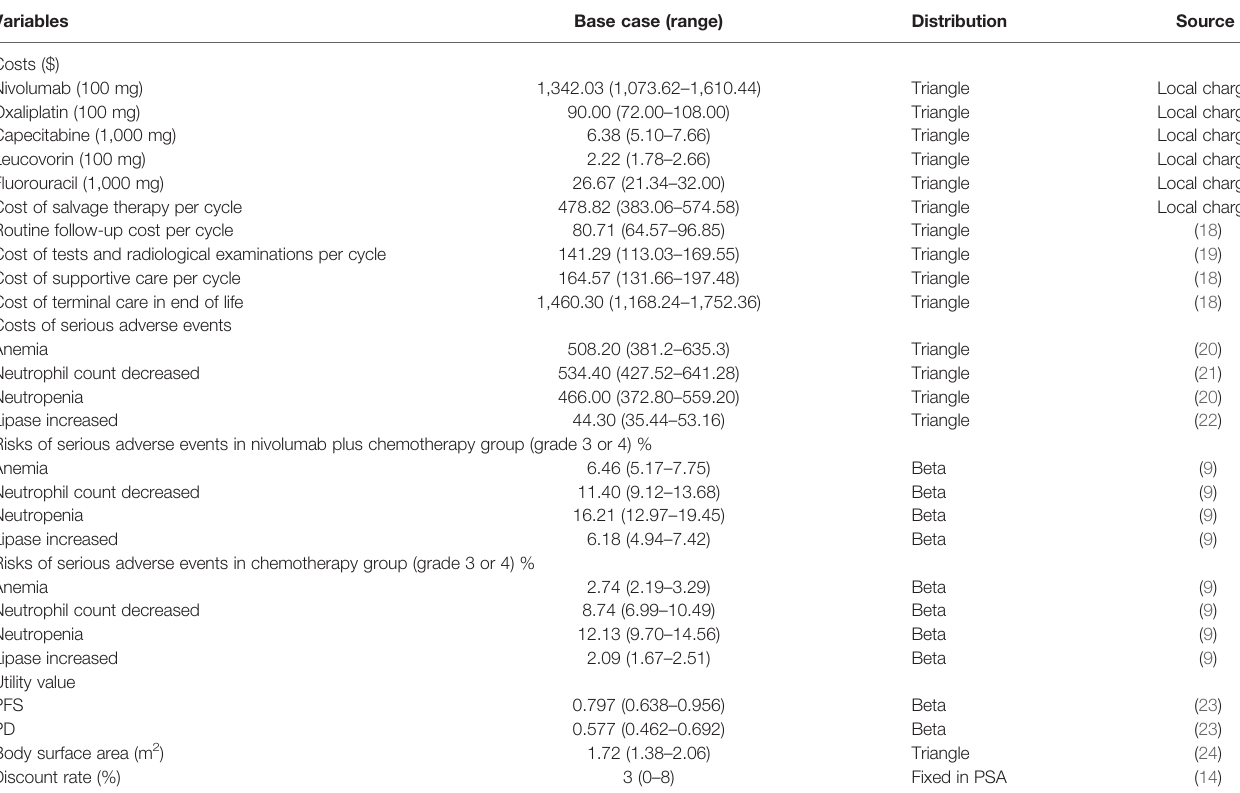
TABLE 2 | Model economic parameters and the range of the sensitivity analysis. Variables Base case